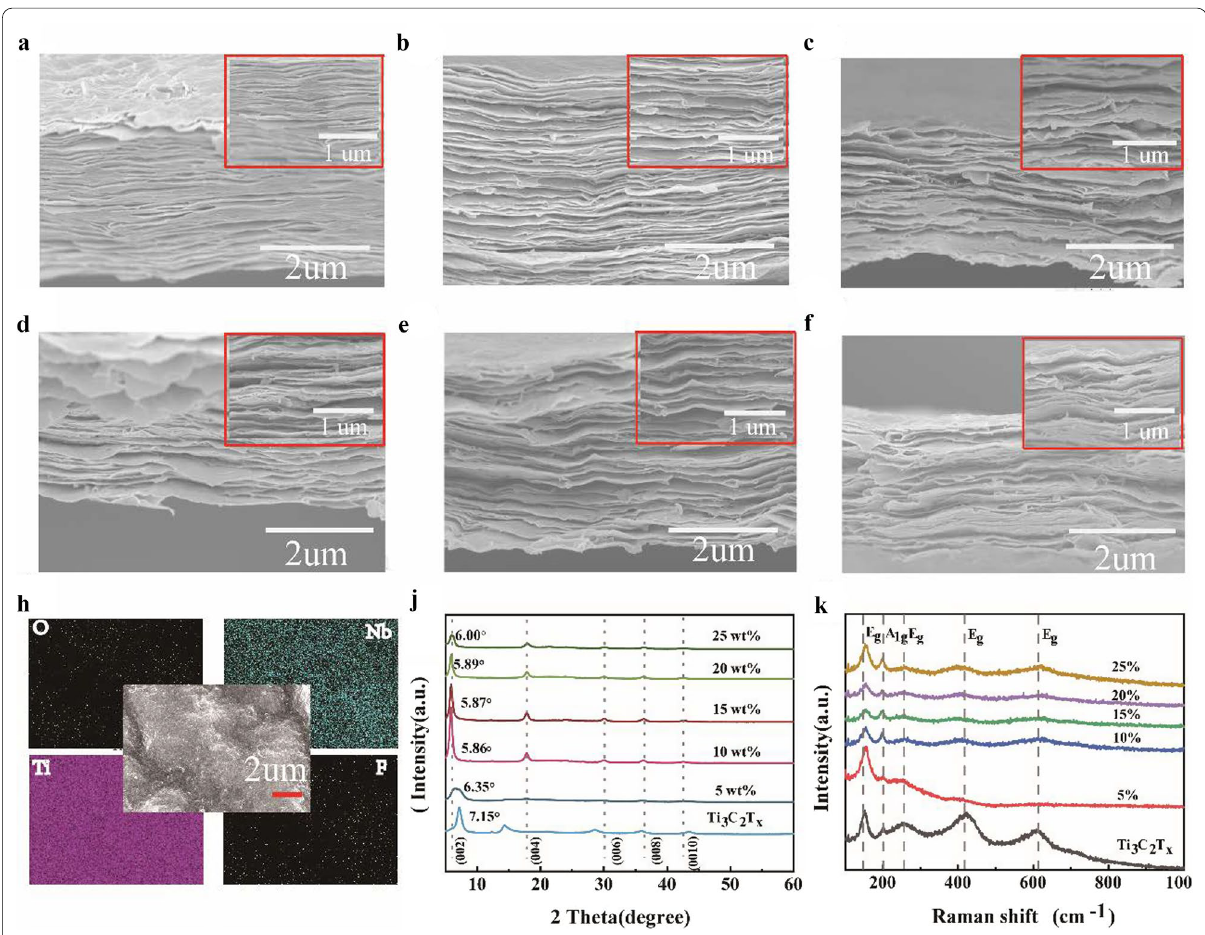
Fig. 2 a The typical SEM image of the Ti 3 C 2 T x film. Cross-sectional SEM image of cross section of alternate-layered MXene composite films with Nb with various